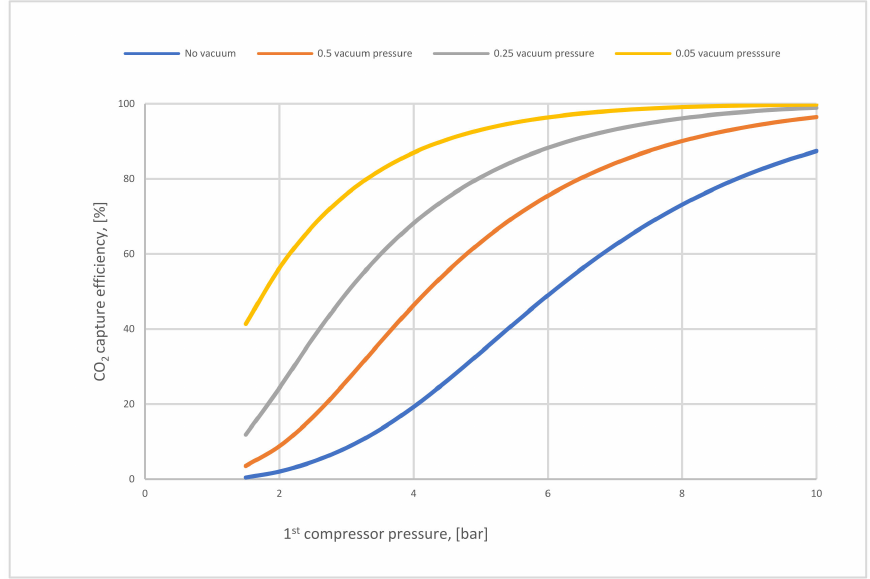
Figure 8. CO 2 capture efficiency regarding different 1st compressor and vacuum pump pressure values for 1-stage (case A, B) at 200,000 m 2 of 1st membrane